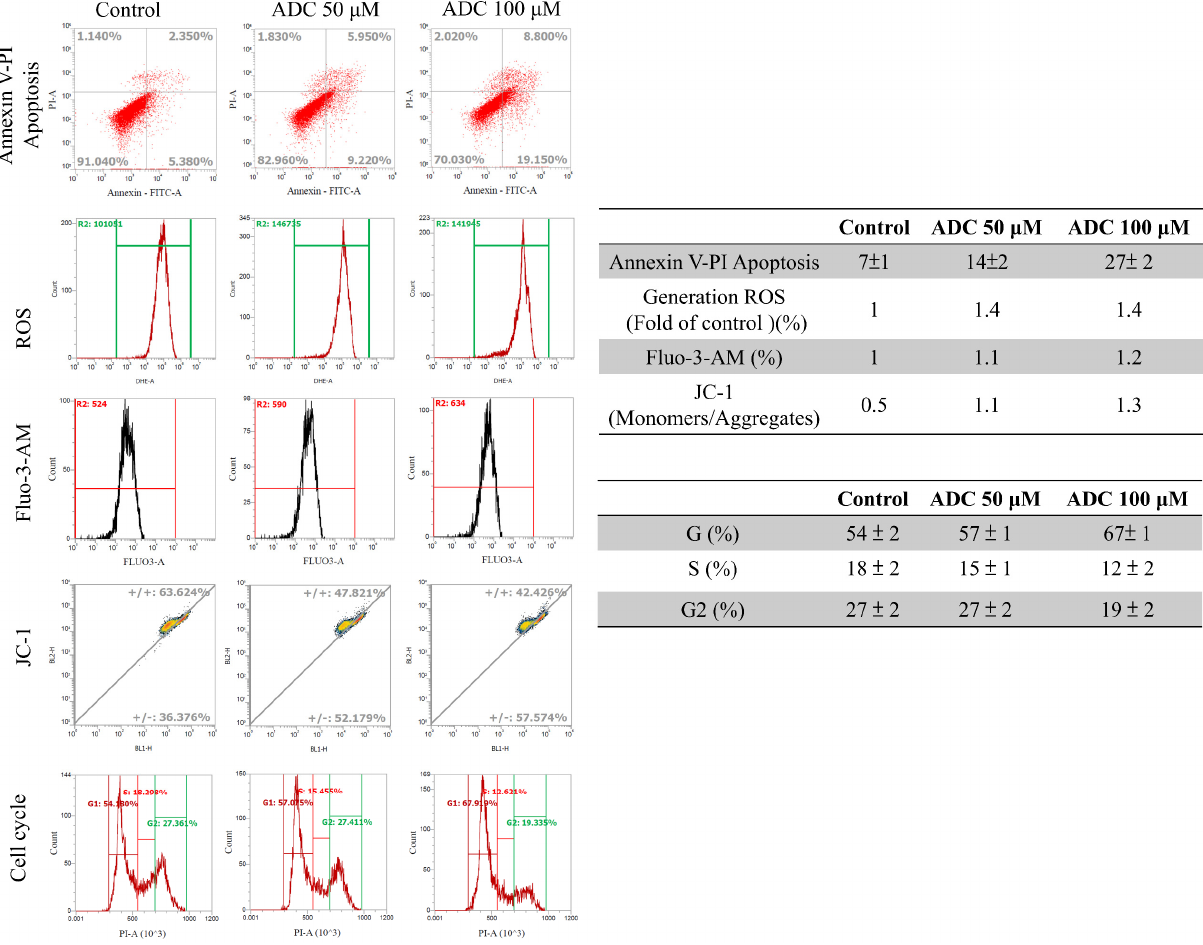
Figure 3. Antrodin C (ADC) induces cell apoptosis and reactive oxygen species (ROS)/Ca2 + produc- tion as well as decreasing mitochondria potential and cell-cycle G1 arrest in HCT-116 cells. After ADC treatment, the HCT-116 cells were stained with FITC-conjugated annexin-V and propidium iodide (PI) analysis. After individual treatment, the percentage of apoptotic cells was indicated. Measurement of the intracellular ROS/Ca2 + of ADC-treated cells was performed by FACS analysis. ROS/Ca2 + production is expressed as the fold change of the control group. The ADC-treated cells were stained with JC-1 stain for flow cytometry analysis. A decrease in the green/red fluorescence intensity ratio detected by ADC revealed the membrane-permeant ADC exhibits potential-dependent accumulation in mitochondria. Flow cytometry results show the percentage of cell numbers involved in each cell-cycle phase (G1, S, and G2/M). Data are presented from a list of three independent experiments as mean ±